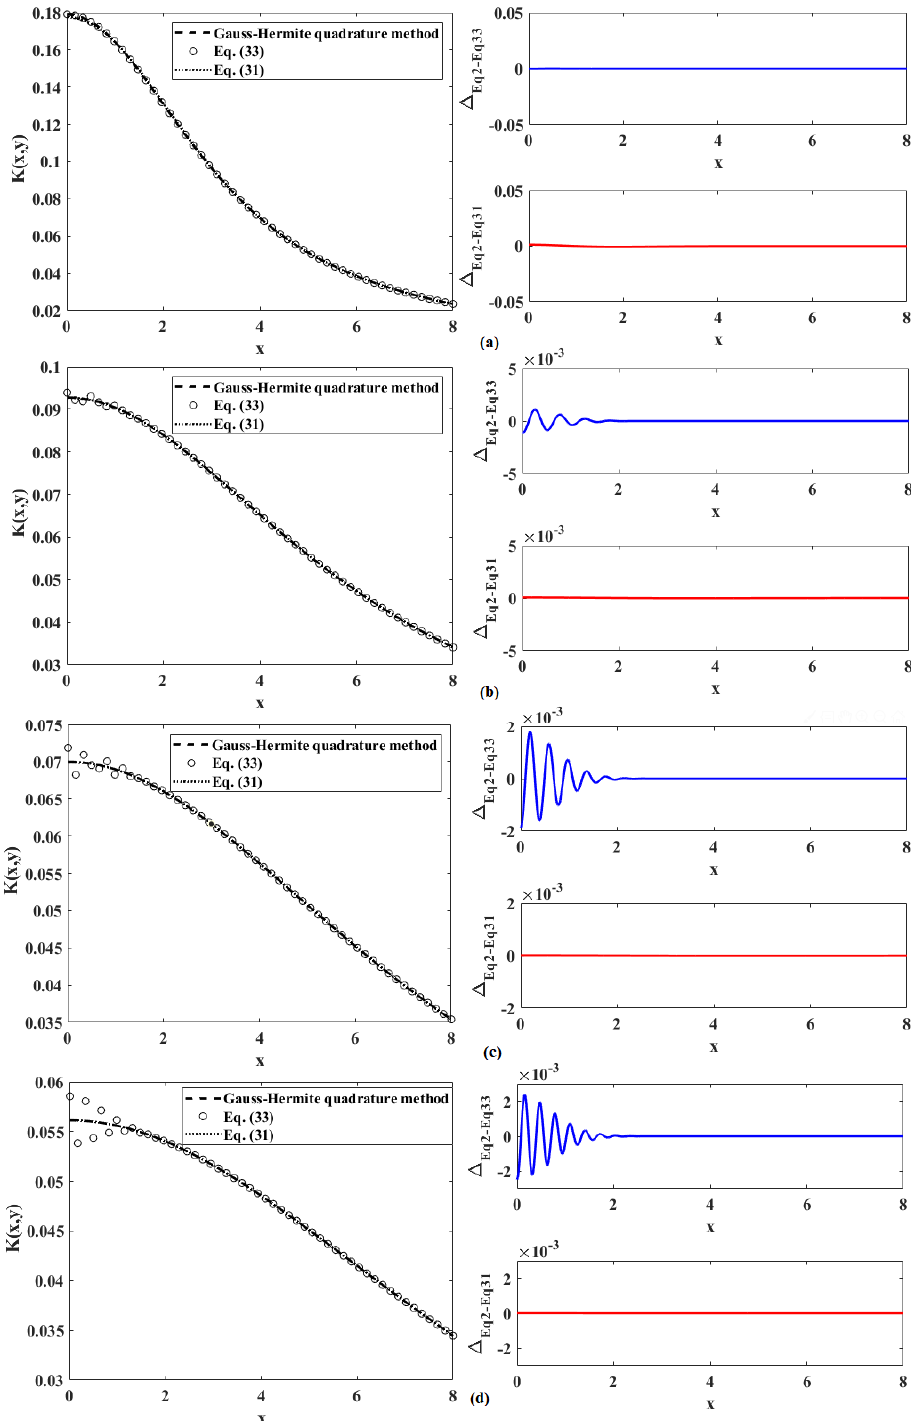
Figure 5. Evolution of the Voigt function K ( x , y ) in terms of x for different values of y : ( a ) y = 3, ( b ) y = 6, ( c ) y = 8 ( d ) y = 10 and on the right side, the plots of the subtraction of the Gauss–Hermite result from the result of Equations (31) and (33).